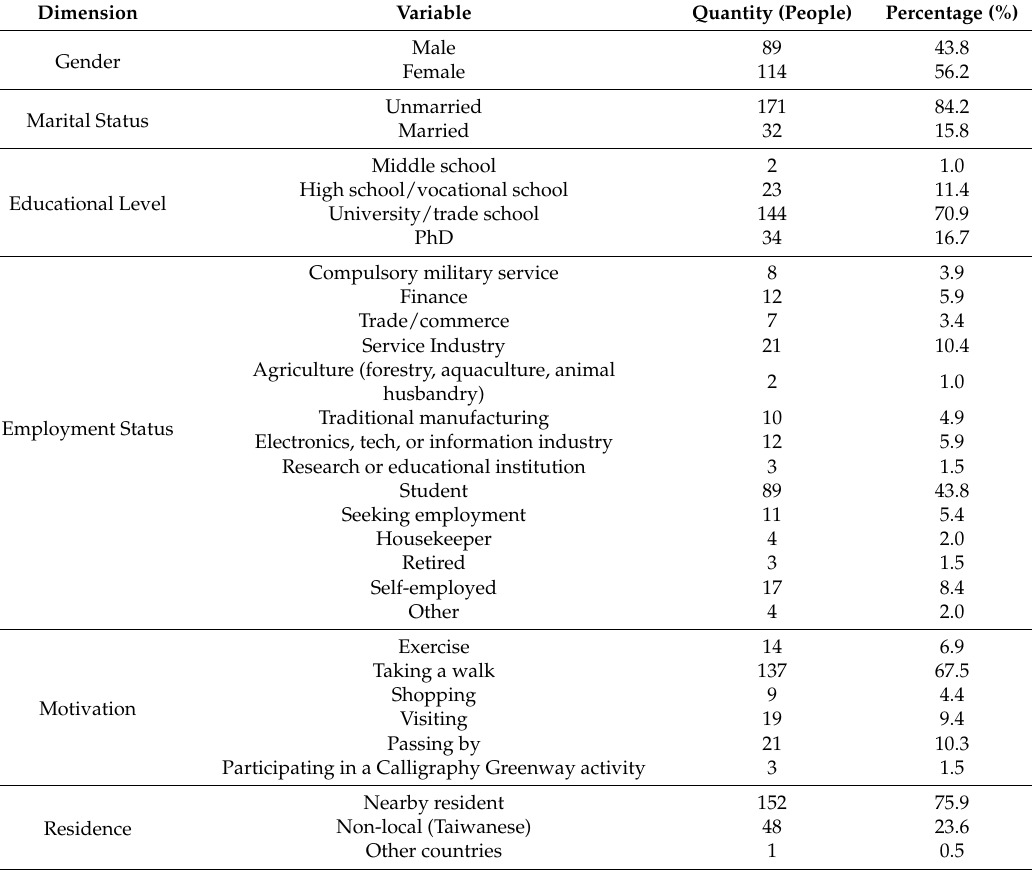
Table 3. Demographic statistics of the visitor sample in this